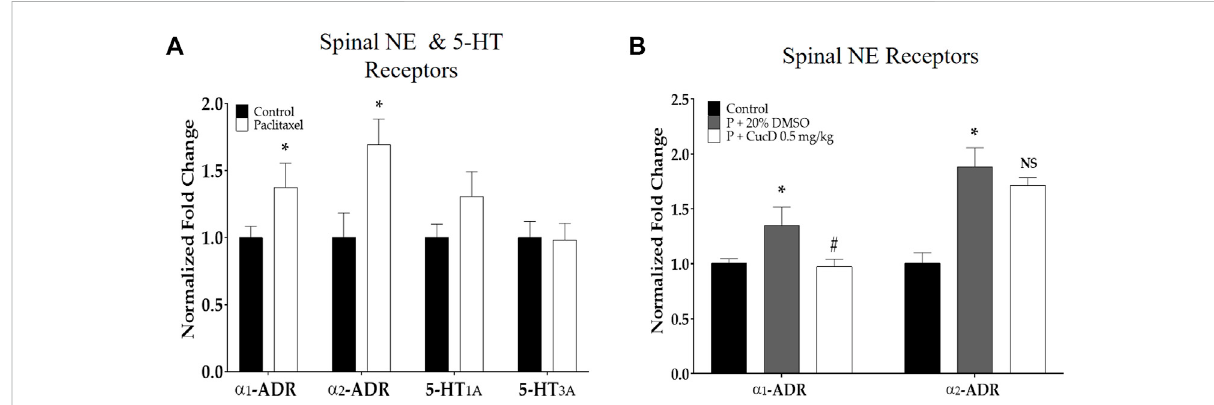
FIGURE 7 Quantitative real-time polymerase chain reaction of adrenergic and serotonergic receptor genes in the spinal cord. The effect of paclitaxel on spinal α 1 - and α 2 -adrenergic and 5-HT 1A and 3A receptors (A) . The effect of i p. cucurbitacin D injection on spinal α 1 - and α 2 -adrenergic receptors on mice with paclitaxel-induced neuropathic pain (B) . α 1 -ADR, α 1 -adrenergic receptor; α 2 -ADR, α 2 -adrenergic receptor; 5-HT 1A, 5-hydroxytryptamine 1A receptor; 5-HT 3A, 5-hydroxytryptamine 3A receptor. N = 6 in each group. Data were experiments and expressed as the mean value ± SD. * p < .05vs.controland# p < .05 vs. P+20%DMSOwithtwo-tailedStudent ’ s t -testAandone-wayANOVA,followedbyTukey ’ spost-testformultiple comparisons (B) .